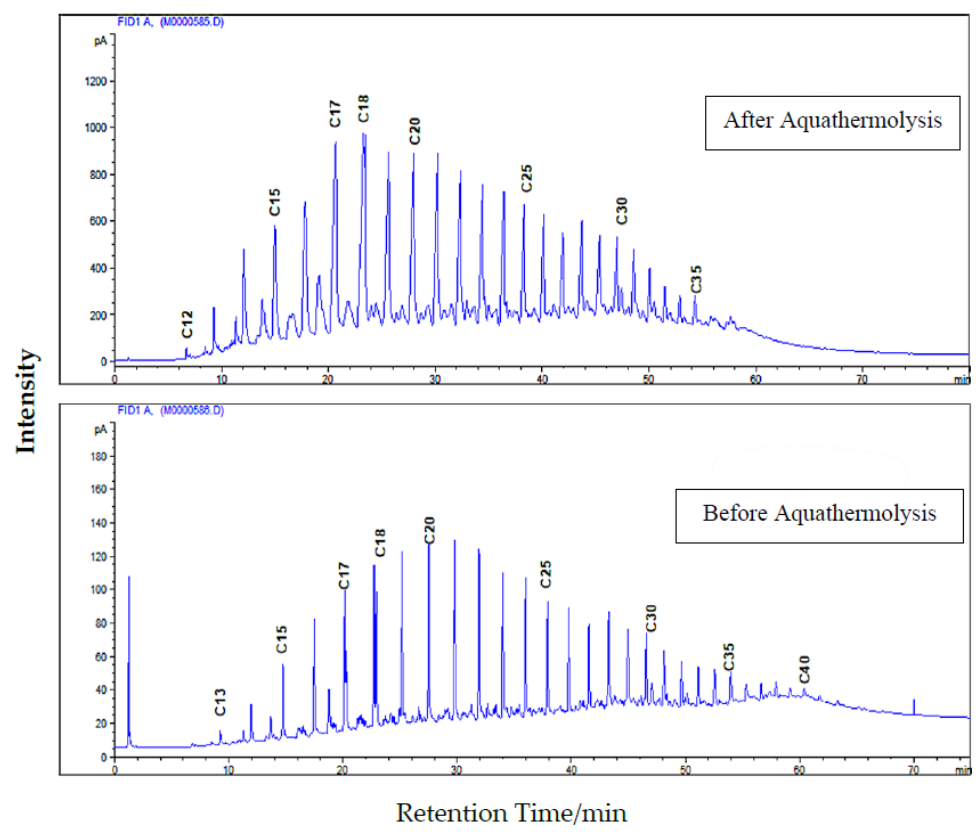
Figure 2. Gas chromatograms of crude oil before and after catalytic aquathermolysis using IL-10.